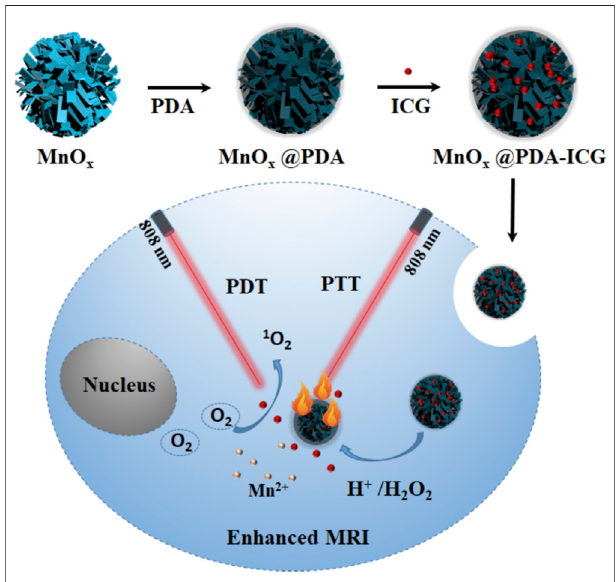
SCHEME 1 | Schematic illustration of MONs@PDA-ICG for enhanced T 1 -guided synergetic photodynamic and photothermal